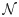
Schematic showing the goal-equivalent (null) space N and goal-relevant (column) space R of fluctuations about an operating point x* on the GEM, and the relative orientation of the weakly (single arrow) and strongly (double arrow) stable subspaces determined by the eigenvectors of a 2 × 2 matrix B (Eq (11)), as given by angles θw and θs, respectively.Also shown are the coordinate axes of the position and velocity fluctuations, p and q, respectively. Note that θw is exaggerated for clarity: we expect θw ≈ 0. The strongly stable direction is transverse, but not necessarily perpendicular, to the GEM.